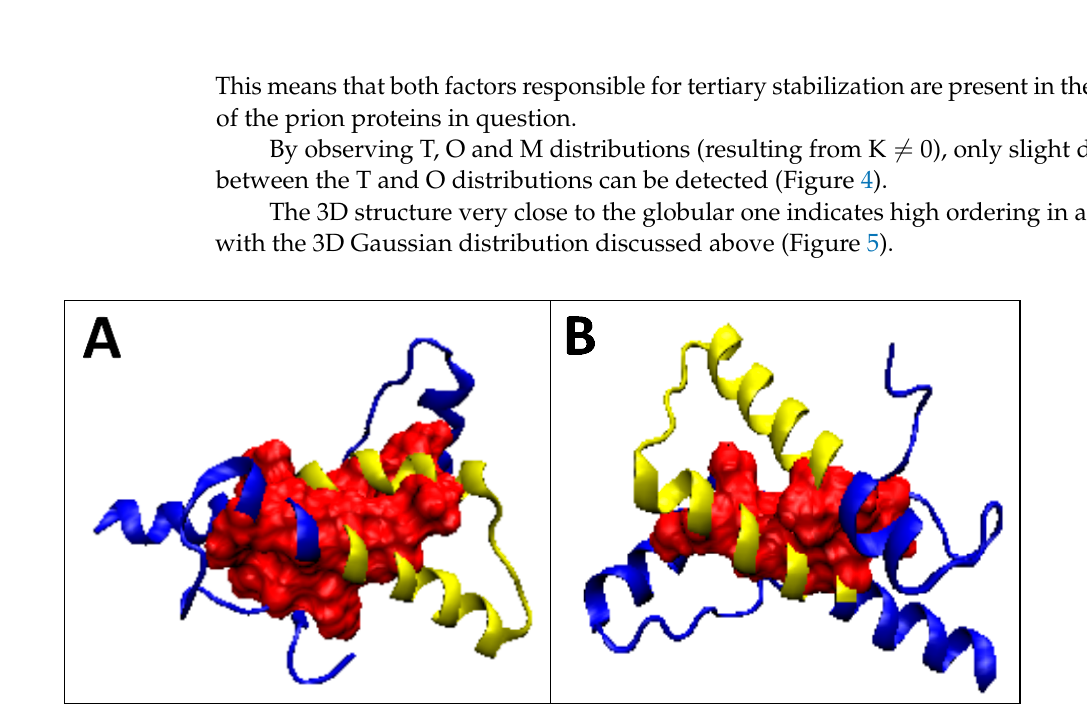
Figure 4. Profiles T, O and M for single-chain prion proteins. ( A ) 1HJN—the section delimited by the disulfide bond is marked with a frame (K = 0 for this distribution); ( B ) 1DX0—the M distribution showing a slight modification of the T distribution is also placed.